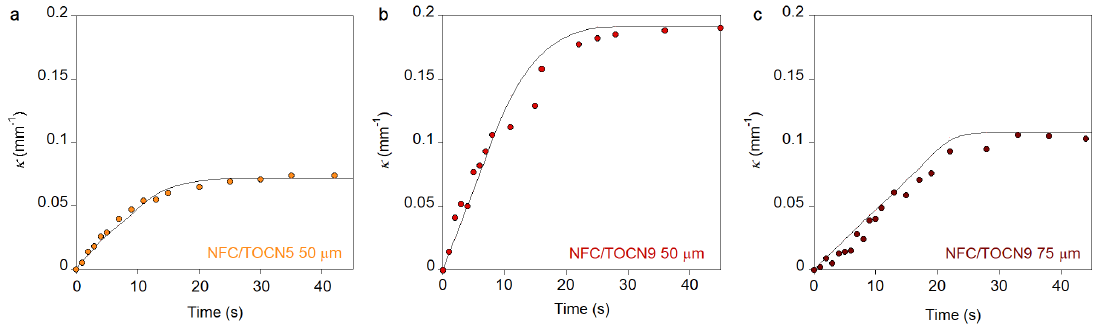
Figure 6. Curvature as a function of time of ( a ) NFC / TOCN5 (50 µ m), ( b ) NFC / TOCN9 (50 µ m), and ( c ) NFC / TOCN9 (75 µ m) nanopapers when they were immersed in high pH aqueous solutions (pH 13). The circles correspond to experimental data and the solid lines represent the fit.